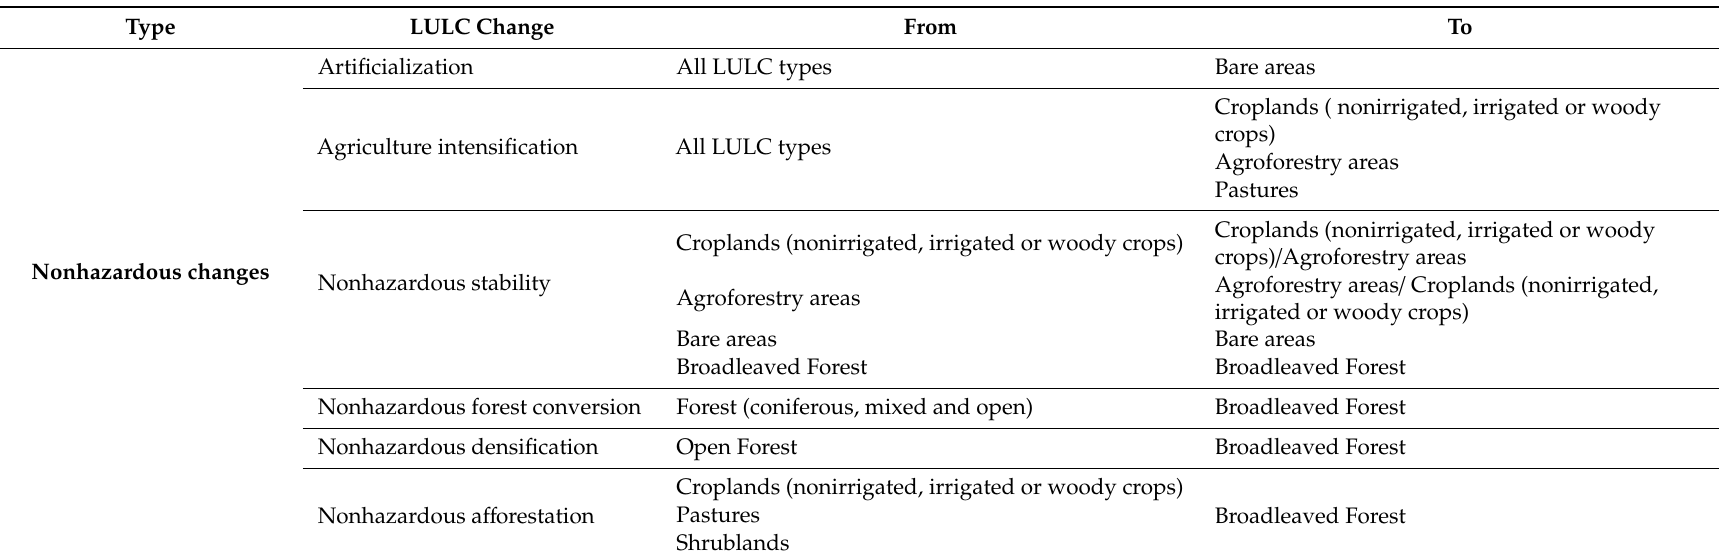
Table A2. LULC change processes categorized by their hazardousness to